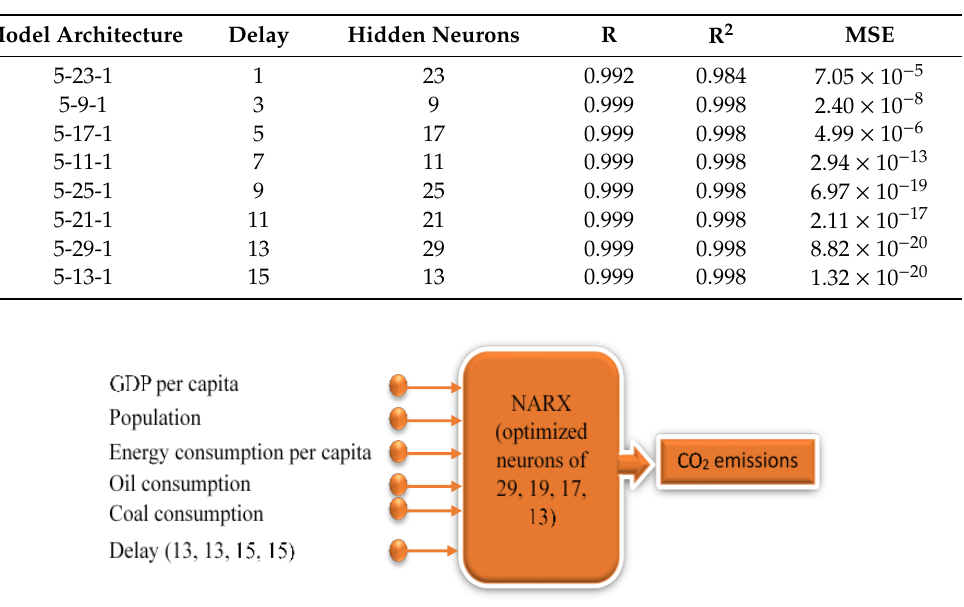
Table 4. Optimized hidden neuron obtained using data for Indonesia. Model Architecture